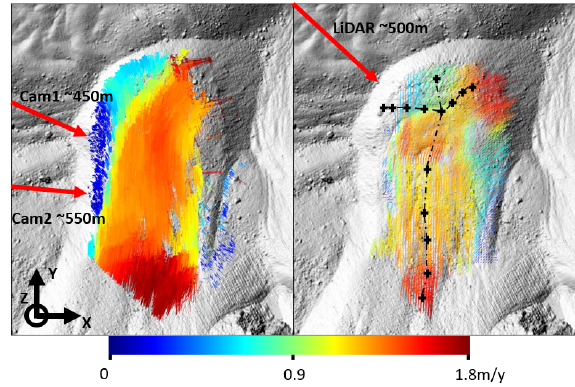
Figure 9. Comparison of two different methods to compute velocity vector field on the Laurichard rock glacier between the 25/09/2018 and the 22/07/2019: left, vector field computed by our stereo device and right, vector field computed by DEM (from LiDAR) cross correlation (Bodin et al., 2018). The stereo displacement vector field is 100 times denser than the LiDAR field. There is no vector on the right side of the glacier with the stereo method due to poor 3D reconstruction in this area (see Figure 7. The red arrows indicates the devices’ point of view and the crosses indicate the rocks measured by